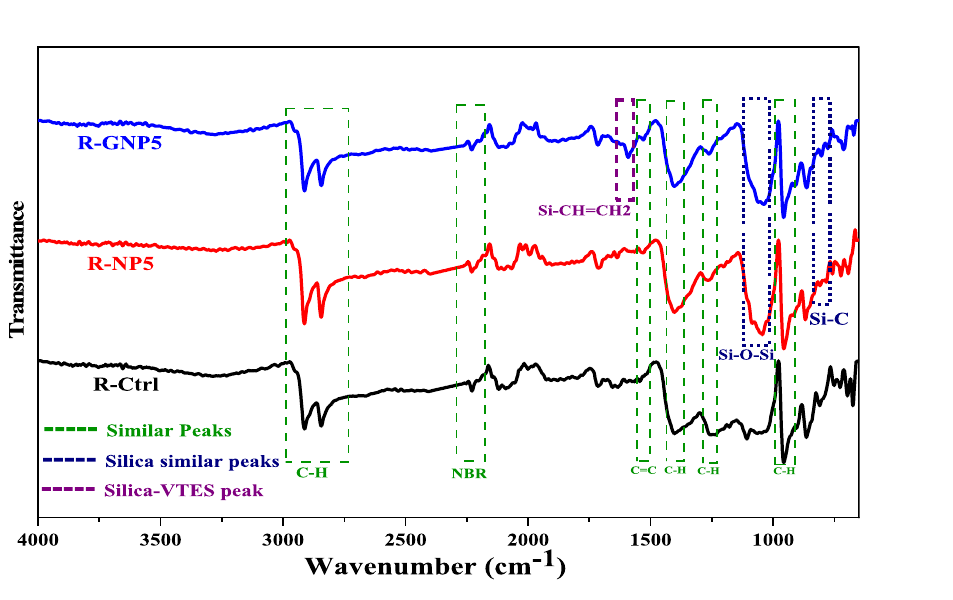
Figure 8. ATR-FTIR spectrums of NBR based